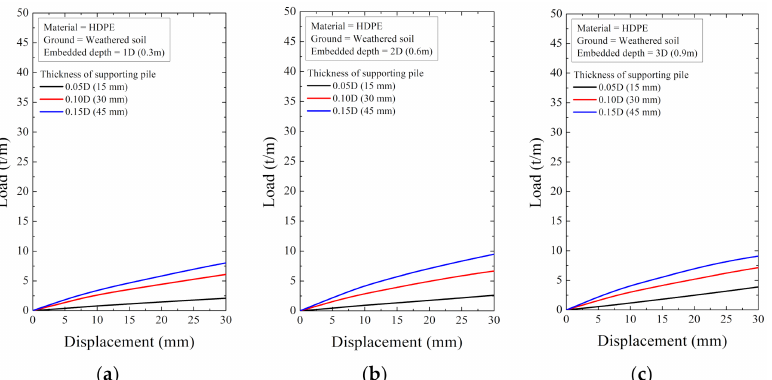
Figure 20. The displacement–load curve when supporting material is HDPE in weathered soil at embedded depth: ( a ) 1D (0.3 m), ( b ) 2D (0.6 m), and ( c ) 3D (0.9